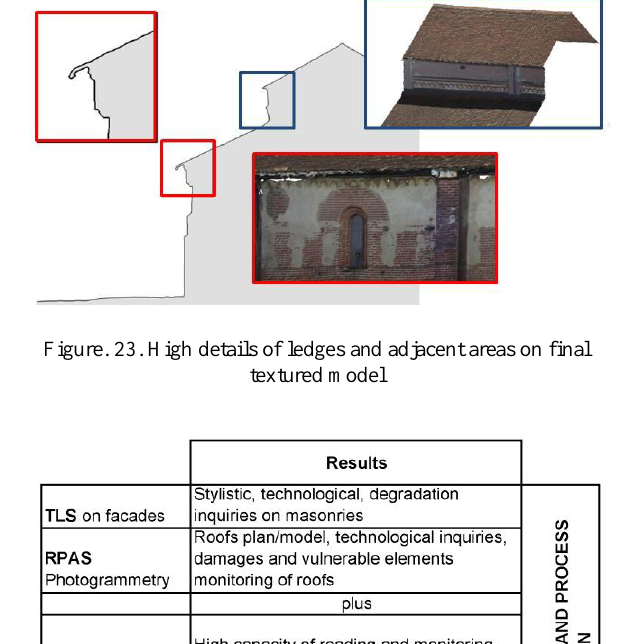
Figure 21. A view of a span of the Church. The mesh has been processed with the “Mesh in two steps” method (distance between points: 0.07 m; deviation error: 0.05 m). The final textured 3Dmodel is on the right.